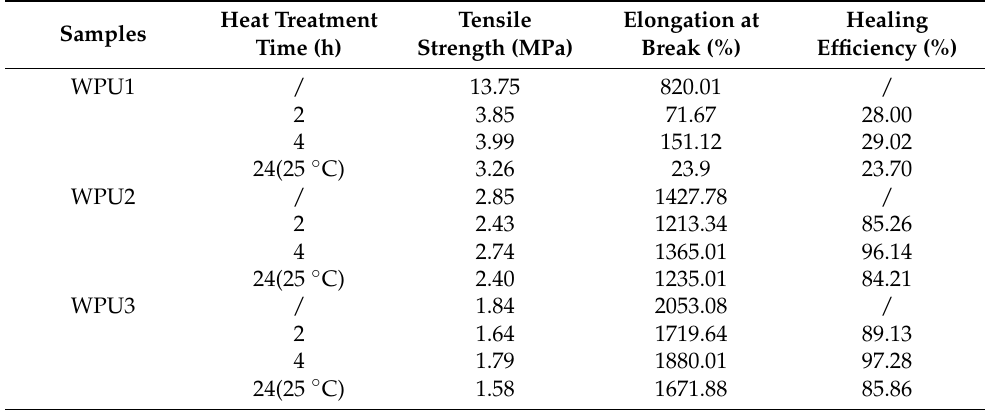
Table 3. DetailsofTensileResultsandtheHealingEfficiencyofWPU-SSSamplesunderdifferentconditions.